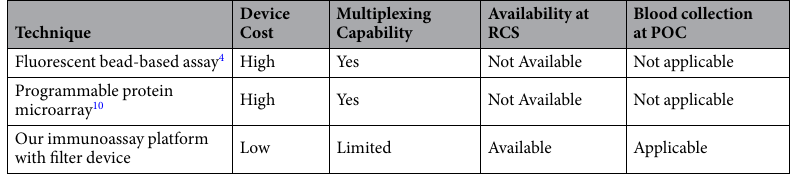
Table 1. Techniques used for detection of HPV16 E7 antibody.